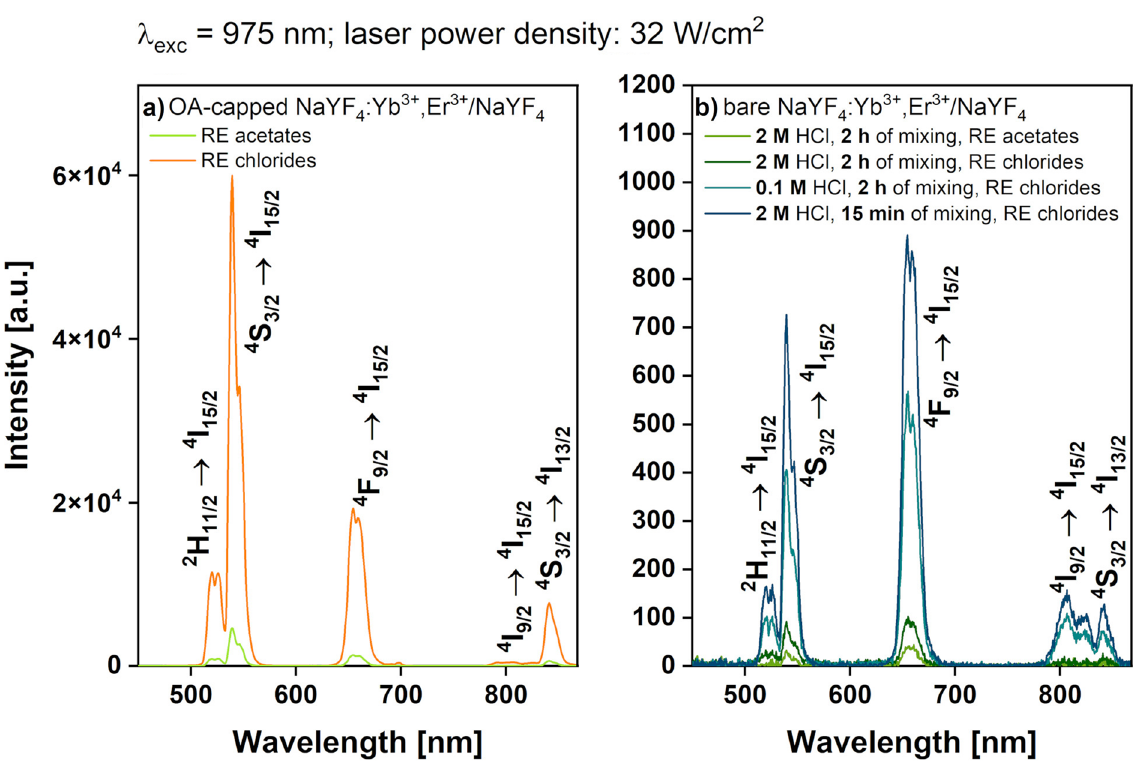
Figure 4. UC emission spectra of ( a ) OA-capped NaYF 4 :Yb 3+ ,Er 3+ /NaYF 4 UCNPs obtained from RE acetates and RE chlorides and ( b ) bare UCNPs after ligand-free modification with three different combinations of HCl molarity and mixing time, λ exc = 975 nm. The NPs’ concentration was 1 mg/mL for both the OA-capped and the bare UCNP